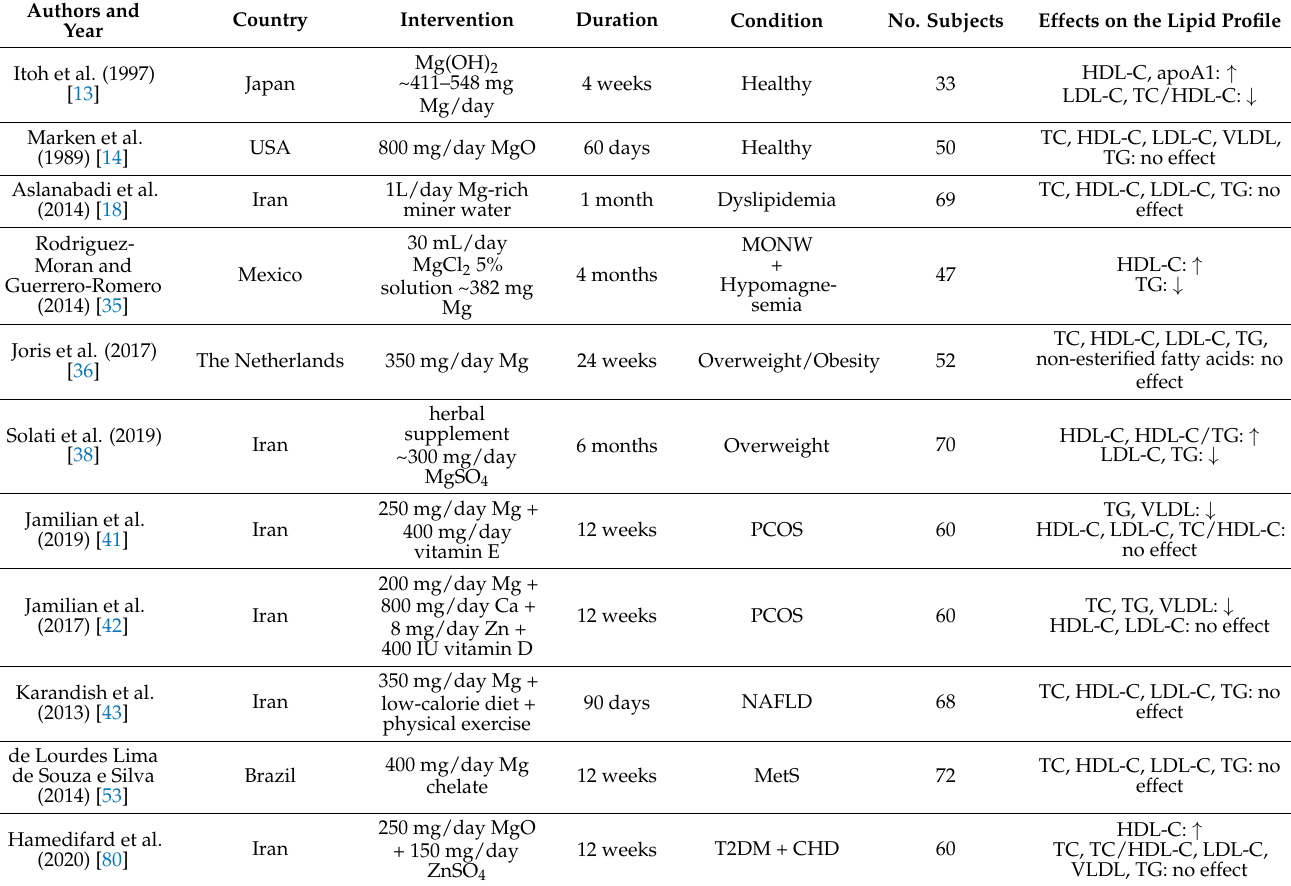
Table 7. Effects of Mg supplementation in